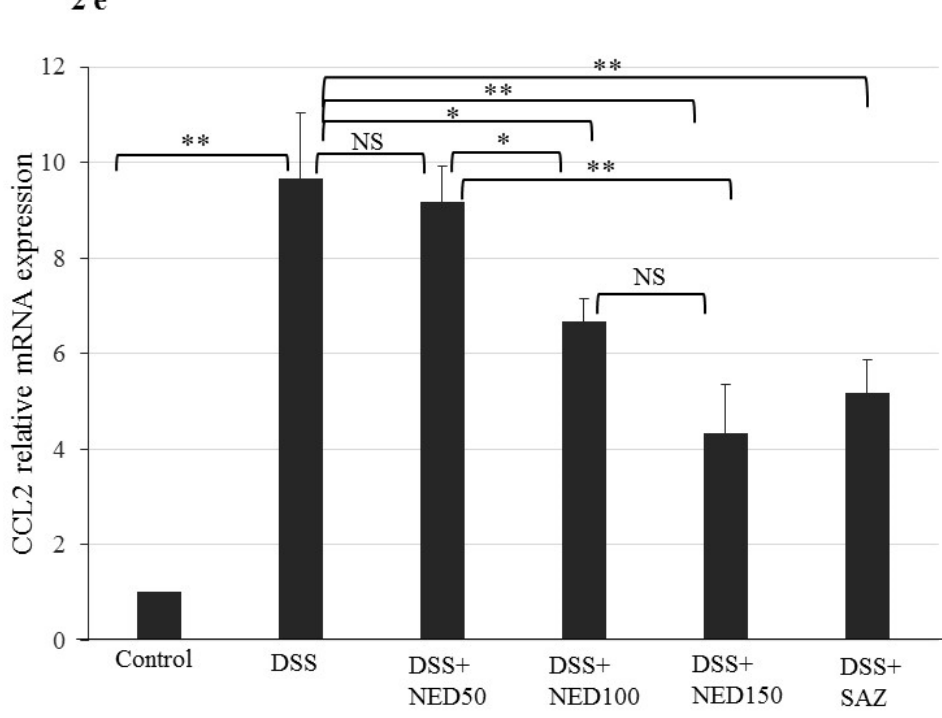
Figure 2. E ff ect of NED on colon length, MPO concentration, CXCL2 and CCL2 mRNA macrophage markers. The mean colon length was significantly decreased in the DSS-treated group. The higher doses of NED-treatment and SAZ-treatment significantly prevented the decrease in colon length compared to DSS group. The lowest concentration of NED had no e ff ect ( a , b ). Data were obtained from n = 10 animals in each group and are expressed as means ± SEM. * p ≤ 0.05. DSS-treatment significantly increased MPO concentrations compared to untreated controls. The higher doses of NED-and SAZ reduced MPO concentrations compared to DSS treatment alone. However, the lowest dose of NED had no e ff ect ( c ). Data were obtained from n = 10 animals in each group and are expressed as means ± SEM. ** p ≤ 0.01 * p ≤ 0.05. DSS-treatment significantly increased colonic CXCL2 and CCL2 mRNA levels compared to controls. The higher concentrations of NED and SAZ-treatment prevented the increase of both CXCL2 and CCL2 mRNA concentrations compared to DSS alone. However, the lowest concentration of NED-had no e ff ect ( d , e ). Data were obtained from n = 8 animals in each group and are expressed as means ± SEM: *** p ≤ 0.001 ** p ≤ 0.01, and * p ≤ 0.05 were considered statistically significant, and NS indicates not